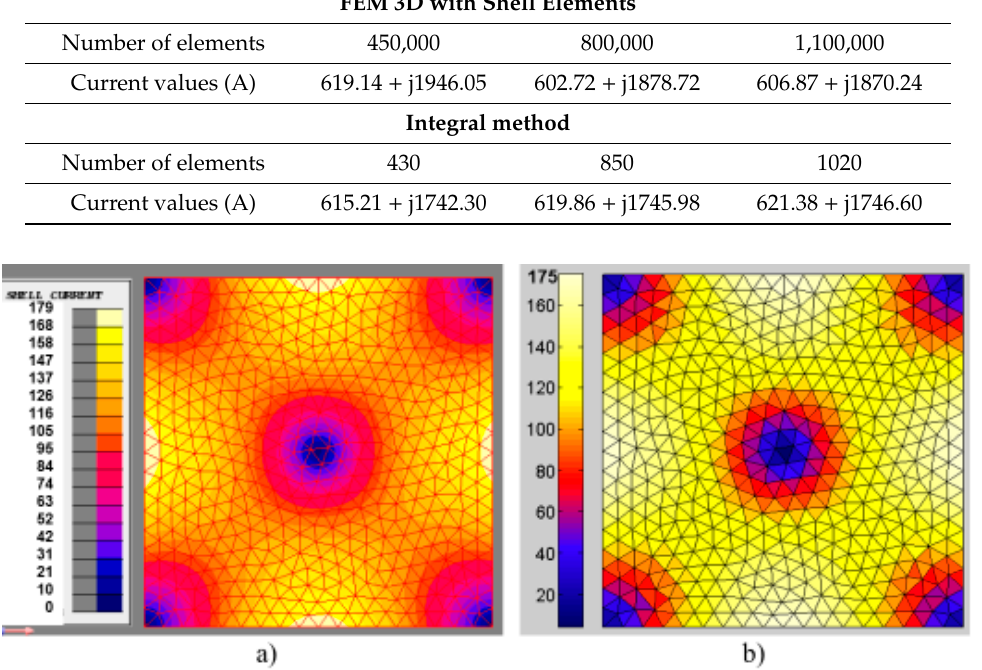
Figure 8. Surface distribution of the current (A/m) in the thin shell for the test case “Folies”: ( a ) FEM 3D with shell elements; ( b ) Integral method.